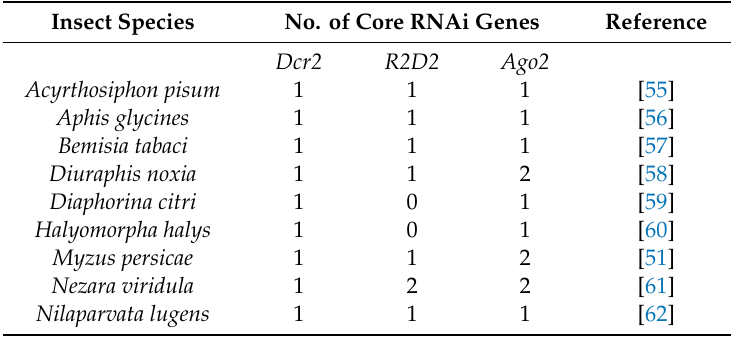
Table 1. Overview of reported core RNAi genes in hemipteran